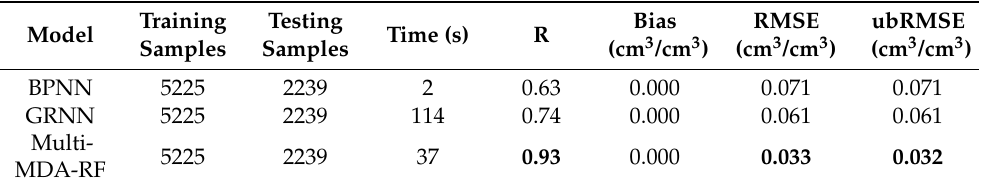
Table 5. The results of Multi-MDA-RF model compared to BPNN and GRNN. The bold numbers indicate better evaluation results.